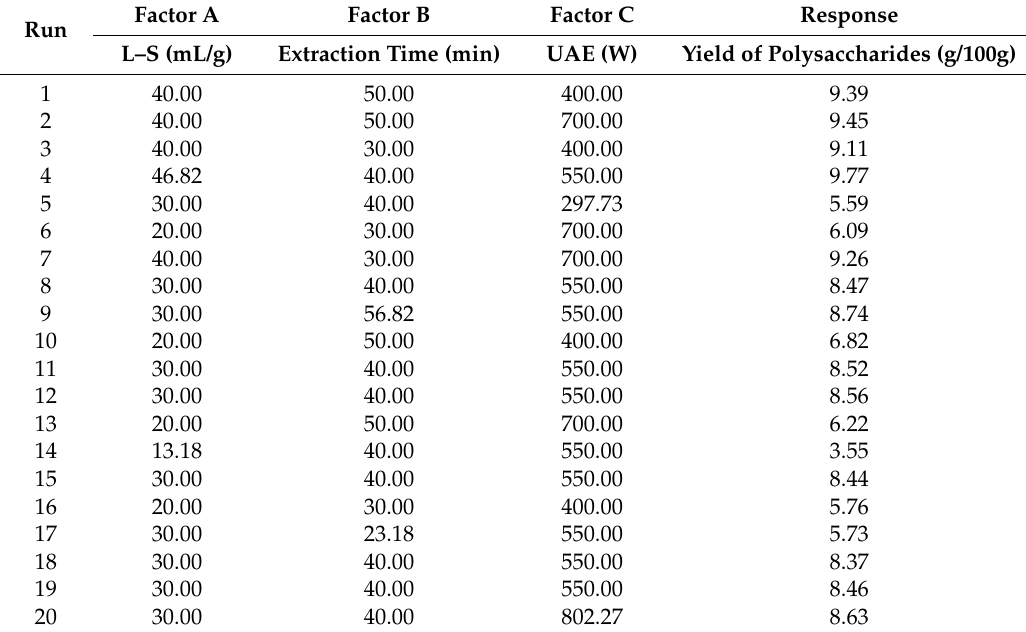
Table 7. Experimental design matrix to screen important variables for ultrasound-assisted